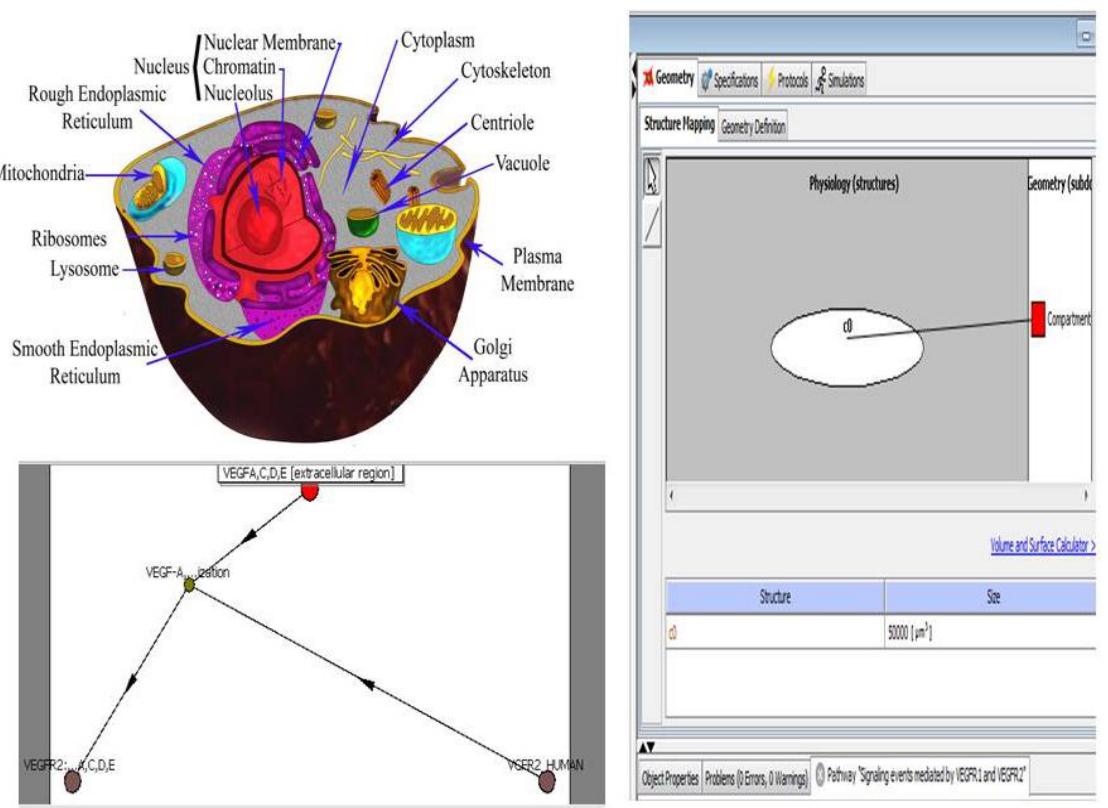
Figure 6. The challenge of understanding intracellular activity is being addressed by computational approaches, such as the Virtual Cell System. While this graphical representation of the VEGF network provides additional information not available by considering the individual pathways separately, it is still a vast simplification. The graphic is merely a static representation of several dynamic processes occurring concurrently with several intertwined feedback loops. The only way to effectively study the effect of either mutations or therapeutic interventions is to create a quantitative model of the network that integrates the dynamics of the individual pathways and their interconnections, which can be simulated on a computer. By representing aspects of an in silico cell, the model can then be used to explore a variety of